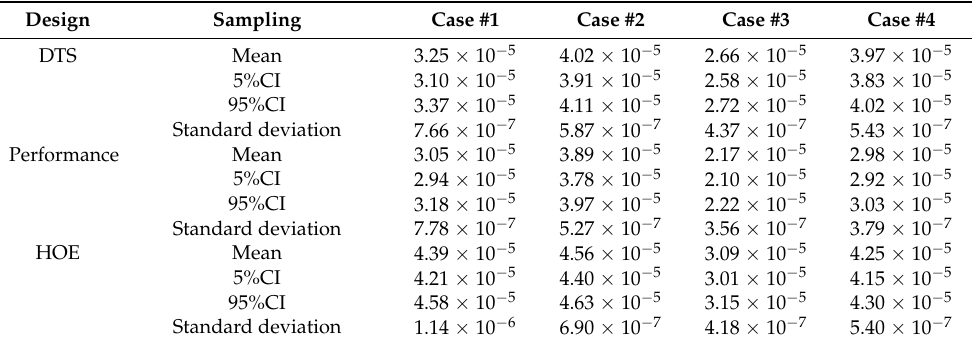
Table 7. Uncertainty analysis of ERL for Case #1 to #4.